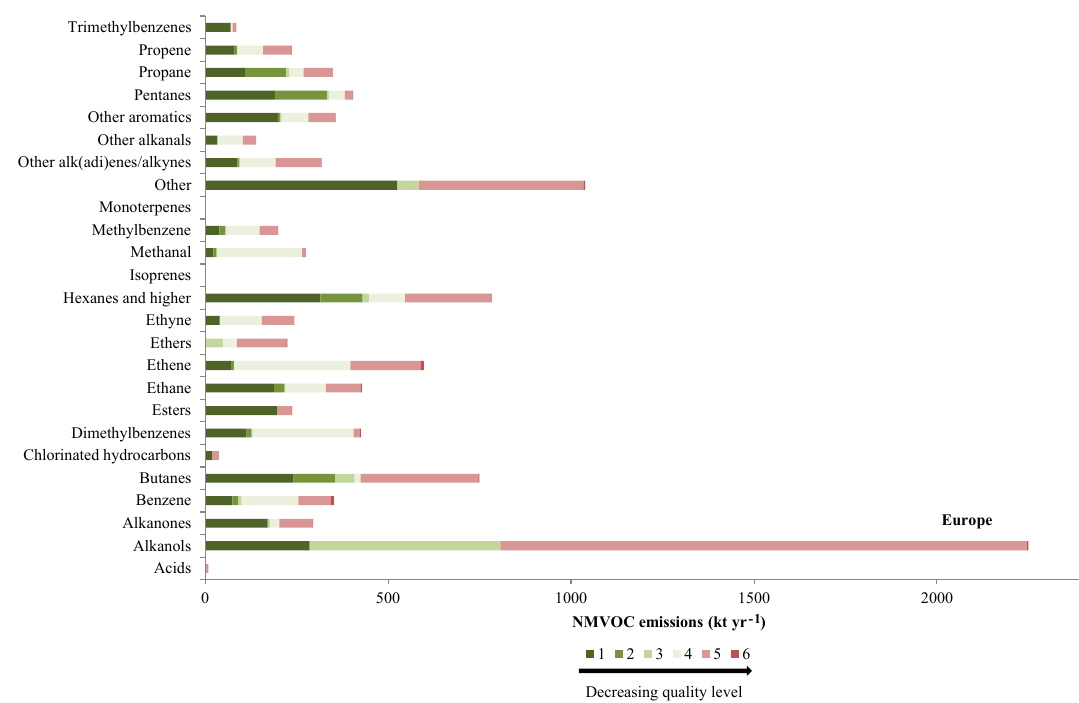
Figure 11. Emissions of 25 NMVOC groups associated with each quality code in 2010 in Europe.